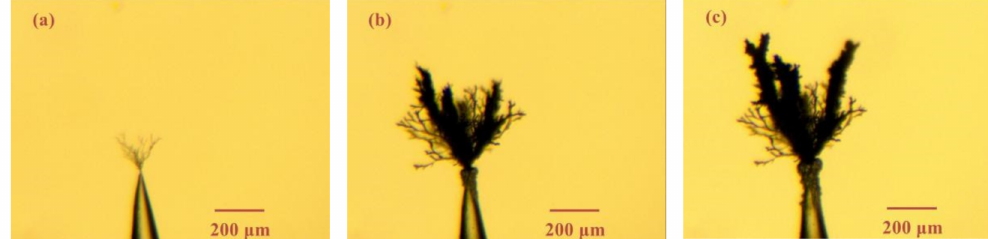
Figure 8. Electrical tree morphology in epoxy resin sample with big air gap under 8 kHz / 8 kV bipolar square-wave voltage at time of ( a ) 5 min, ( b ) 20 min, ( c ) 40